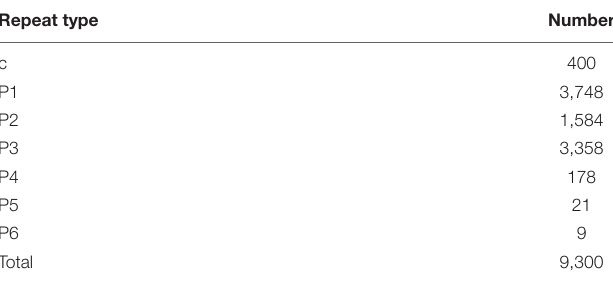
TABLE 3 | Density distribution of different types of simple sequence repeat